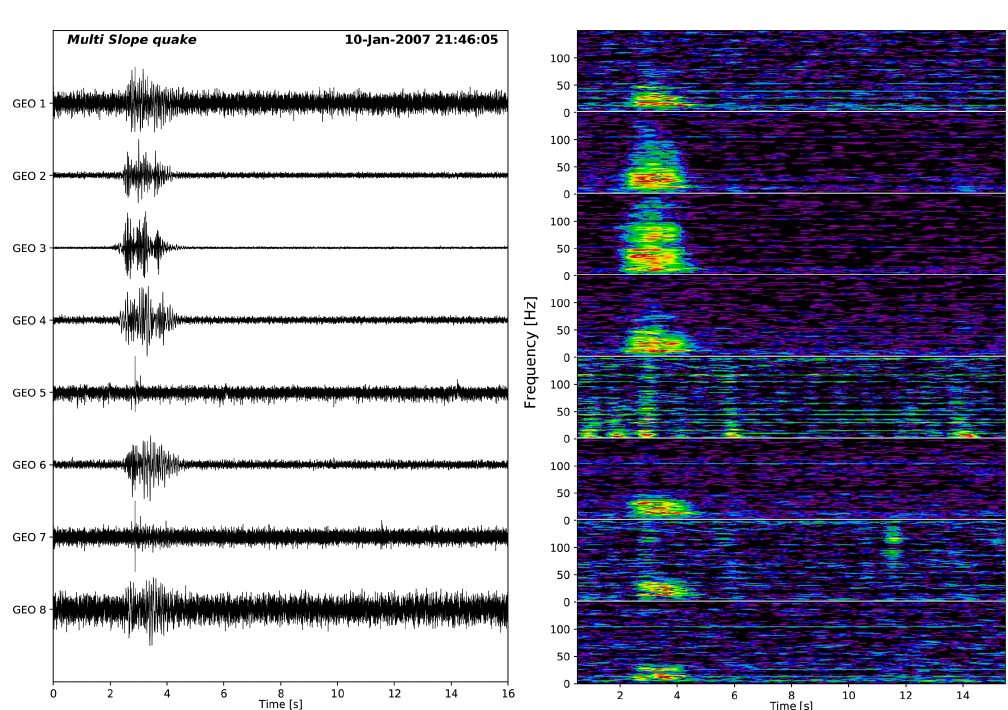
Figure B4. Example of a succession of slope quakes. Geophone 5 was not functional, while geophones 1, 7, and 8 were noisy.